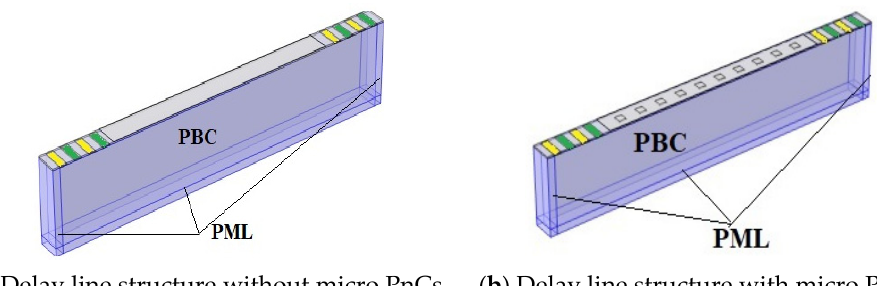
Figure 5. The quasi-three-dimensional models of delay line structures with and without micro PnCs.